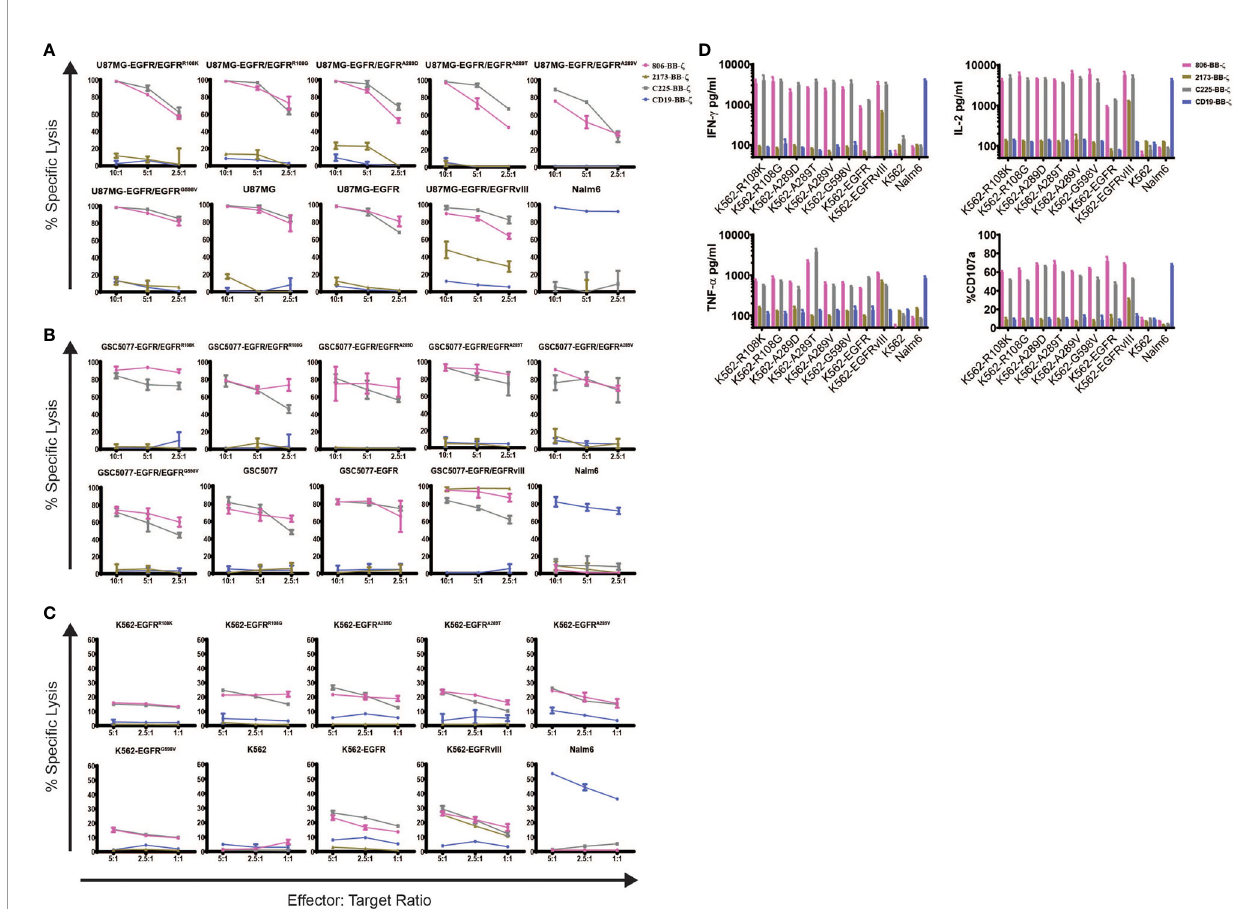
FIGURE 2 | In vitro characterization of 806 EGFR CAR T cells. Antigen-speci fi c cytolytic activity of 806 and 2173 CAR T cells against cell lines expressing EGFR and its variants. (A) U87MG-EGFR and GSC5077-EGFR cell lines expressing EGFRvIII, EGFR R108K/G , EGFR A289D/T/V , and EGFR G598V mutant variants were stably transduced with Click Beetle Green (CBG) and cocultured with CAR T cells at indicated effector-to-target ratios for 24 h. One representative experiment from three normal donors is shown. Samples were performed in triplicates in three replicative experiments. C225-BB- z CAR, and CD19-BB- z CAR were used as positive and negative controls, respectively. (B) Antigen-speci fi c cytolytic activity of 806 and 2173 CAR T cells in EGFR and its variants expressed in K562 cells in a 4-h chromium release assay atindicated effector-to-target ratios. (C) K562 cells expressing wtEGFR,EGFRvIII, orEGFR-mutants were cocultured with 806 CART cells for 48 h.IFN- g , TNF- a , and IL2secretion was measuredin the supernatant by ELISA. Bar charts represent results from a single experiment, andvalues represent the average ± SD of triplicates. (D) CD107a upregulation onCAR T cellsstimulated with K562 cells expressing wtEGFR, EGFRvIII, or EGFR-mutants for 4 h.The percentage of CD107a expression was quanti fi edonCD3 cells (values represent the average of ± SD of two